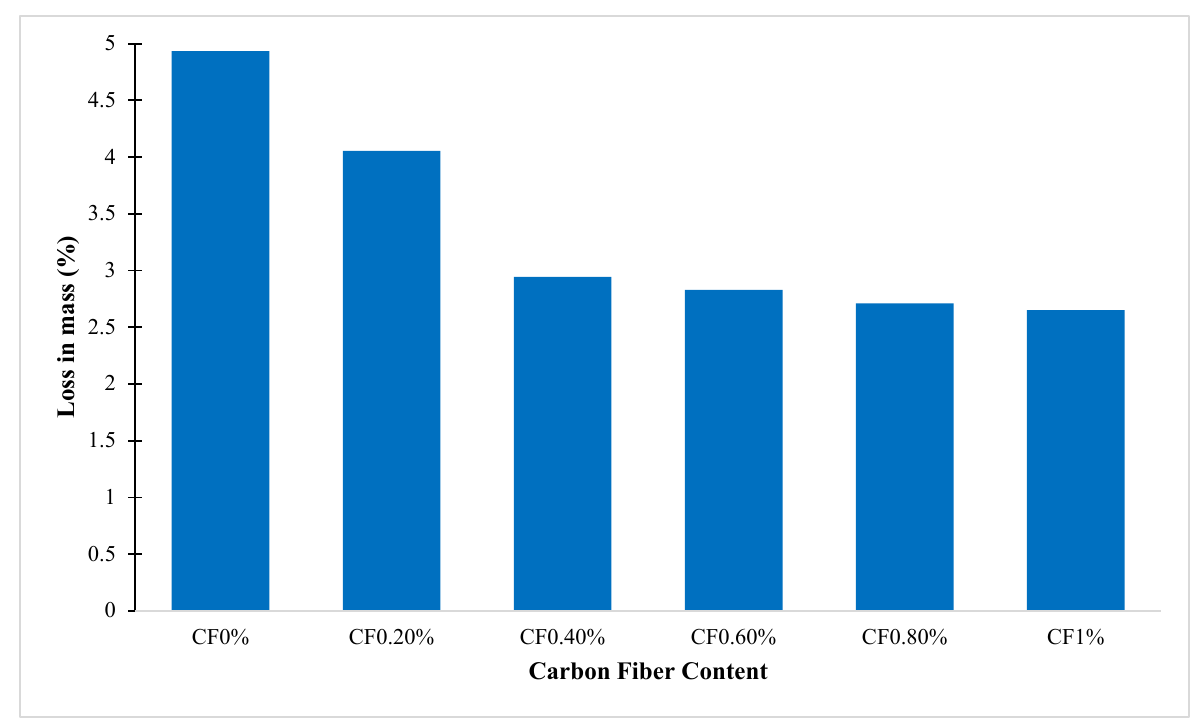
Figure 10. Acid attack test.